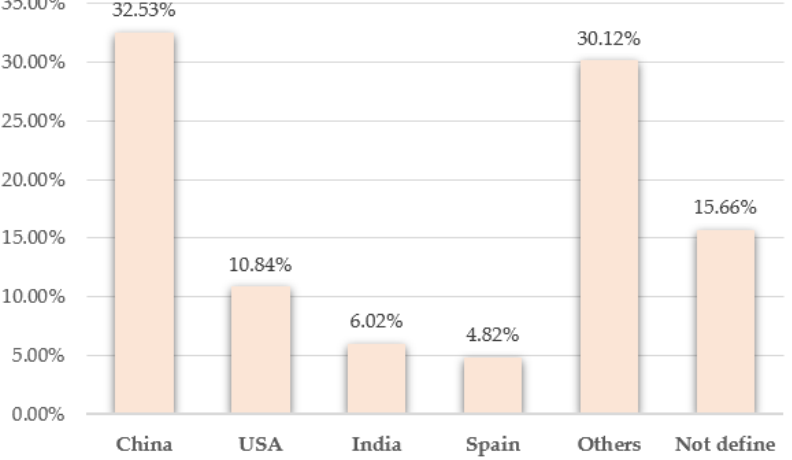
Figure 12. Percentage distribution of countries with data sets most used to evaluate forecast mod- els.